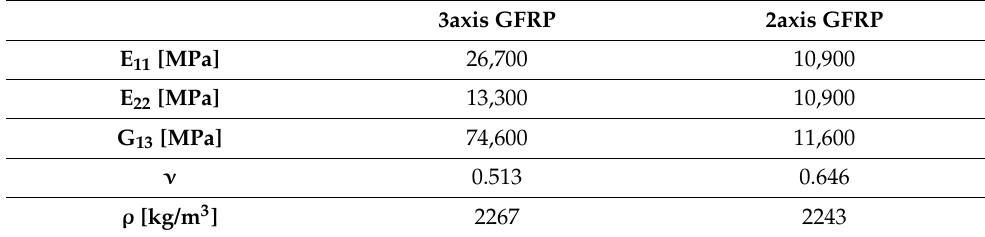
Table 2. Material properties of GFRP composites.